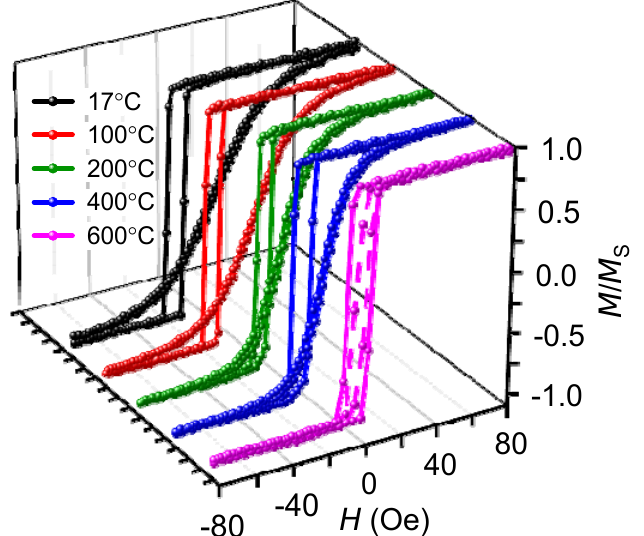
Figure 4. Hysteresis loops, measured at room temperature for the samples NiFe (40 nm)/FeMn (20 nm) with different temperatures of substrate during deposition, along a sample easy axis and hard axis.